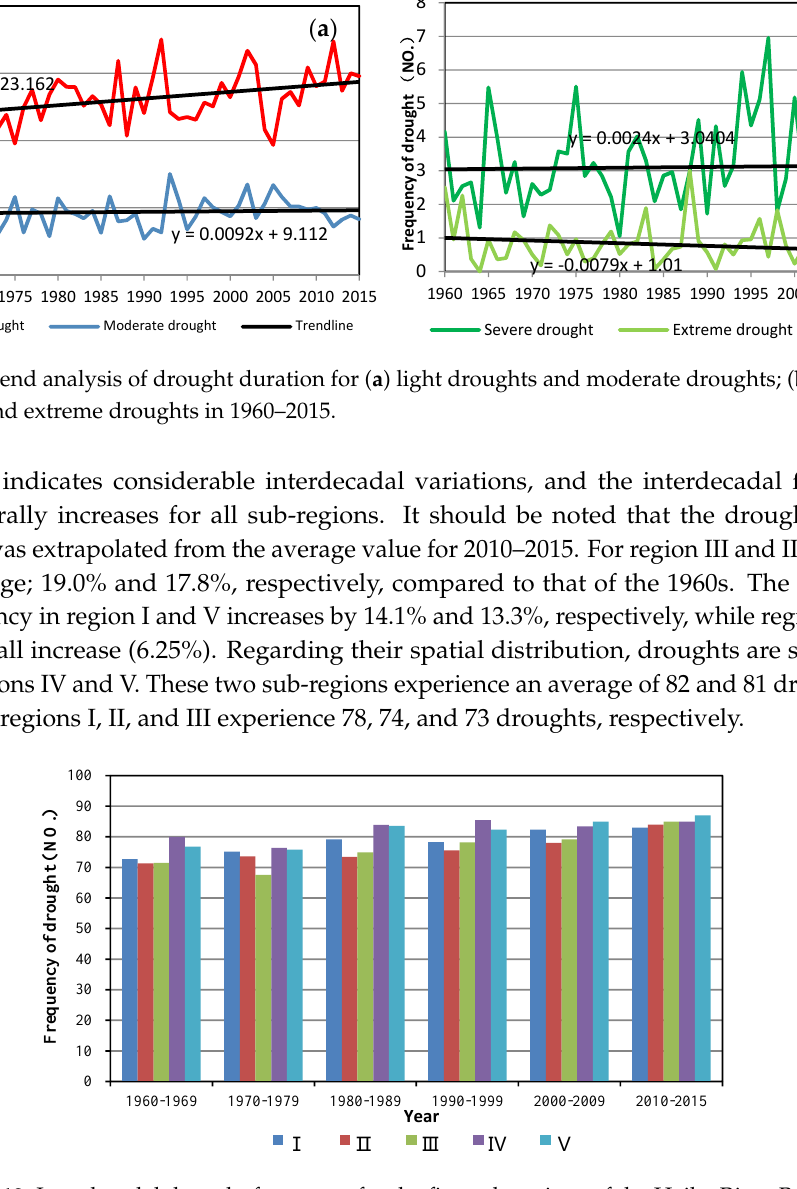
Figure 10. Interdecadal drought frequency for the five sub ‐ regions of the Haihe River Basin.